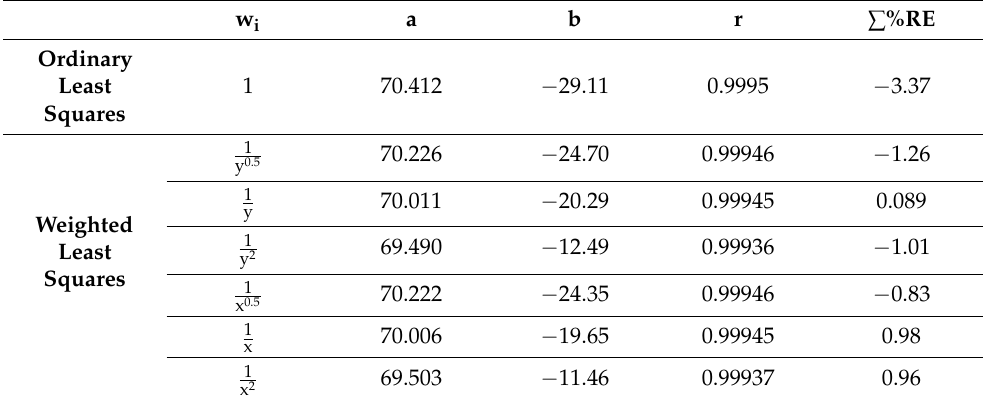
Table 3. Regression parameters of the analytical curve and sums of the relative errors ( Σ %RE).